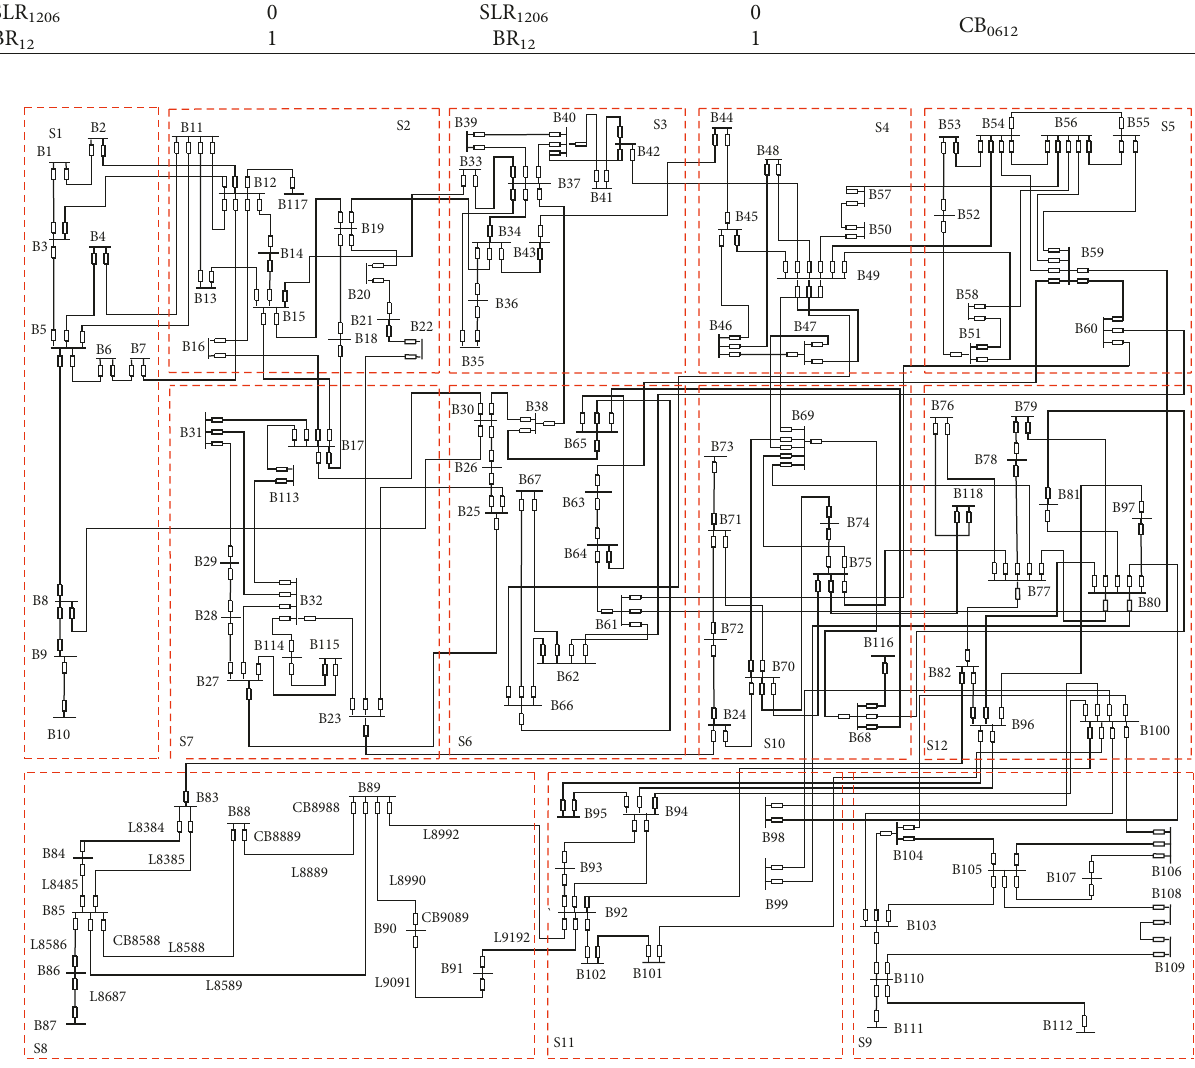
Figure 11: The partition result of the IEEE 118-bus system.